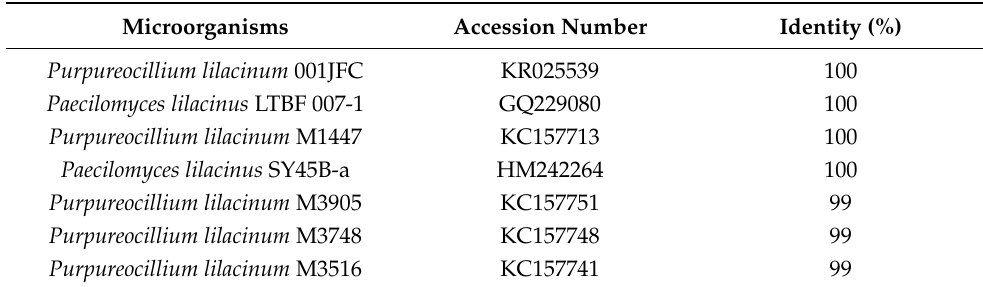
Table 1. BLASTN analysis of the ITS-5.8S sequence of the strain 001JFC with that of other similar fungi (NCBI